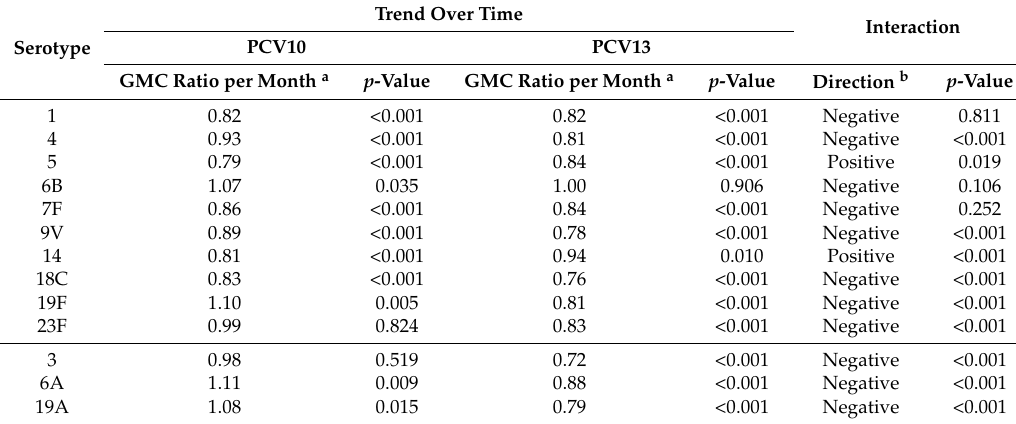
Table 1. Comparison of PCV10 and PCV13 antibody levels over time, with exact age at blood sampling as continuous variable and exchangeable correlation structure.